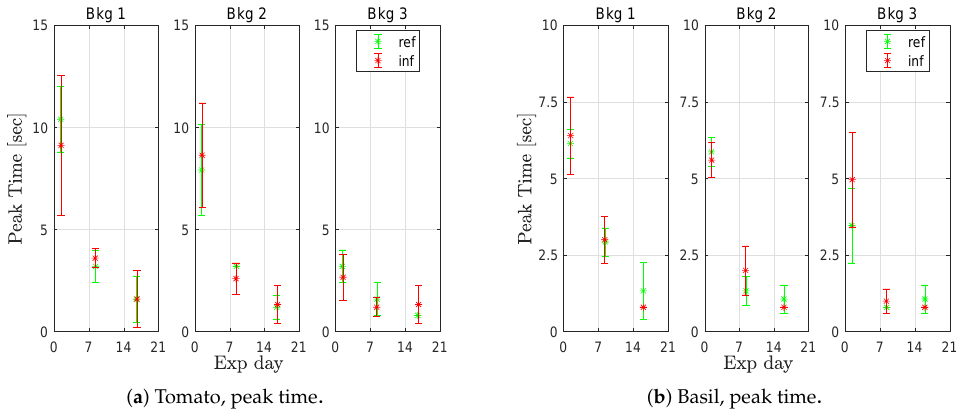
Figure 10. The fluorescence step response peak time for tomato ( a ) and basil ( b ) at three different background light levels. The mean value and std for two to five measurements each week and for each group (reference and infected with Pythium ultimum